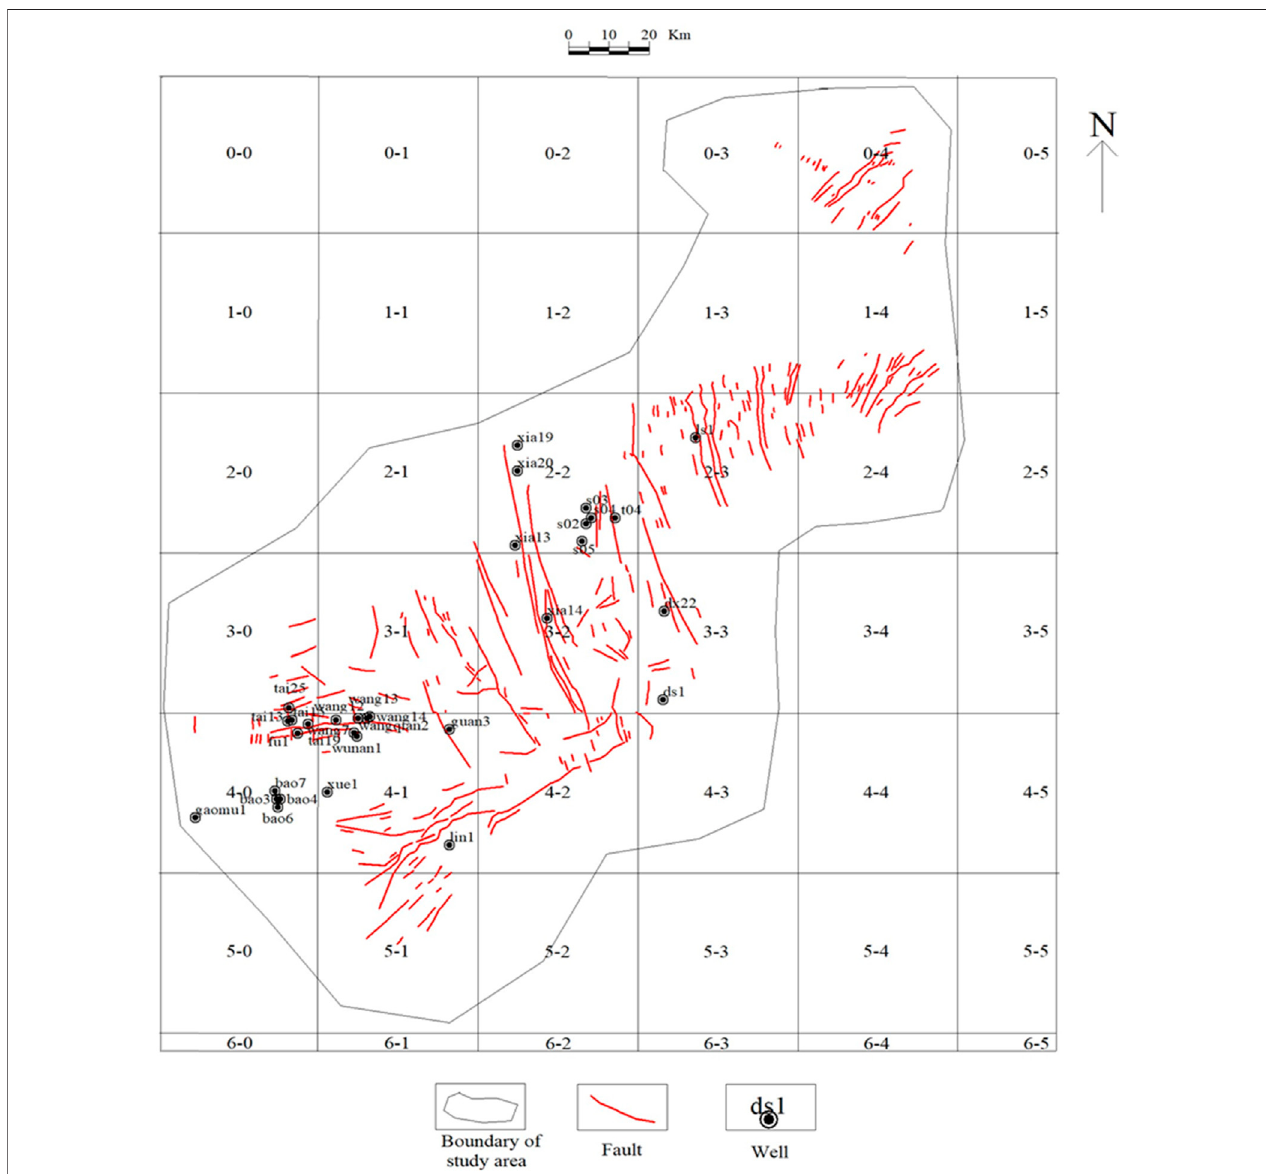
FIGURE 3 | Fault distribution map of Maokou Formation in southeast Sichuan (modi fi ed from Hu et al., 2014).